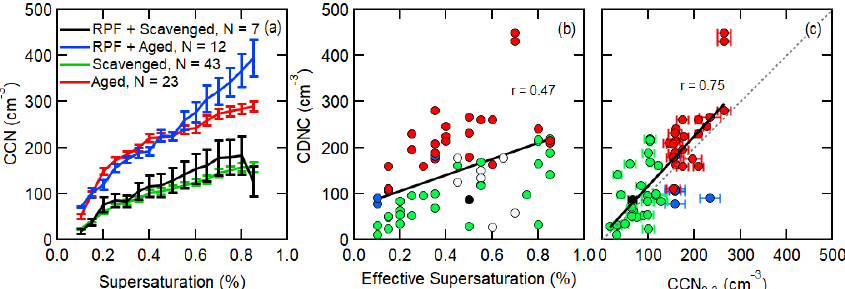
Figure 3. (a) Mean MBL CCN spectra for each regime. The number of samples ( N ) at each supersaturation of the CCN spectra varied from the number of samples in the legend because CCN spectra scans were occasionally not fully completed by the end of the MBL leg. Error √ N ). Correlations of measured CDNC with (b) calculated effective supersaturation and (c) measured bars represent the standard error ( σ / MBL CCN 0 . 3 . Empty points did not have a corresponding CCN 0 . 3 or CN measurement. Solid lines in (b) and (c) represent linear fits and the dashed line in (c) represents the 1 : 1 line. Error bars represent the standard error.